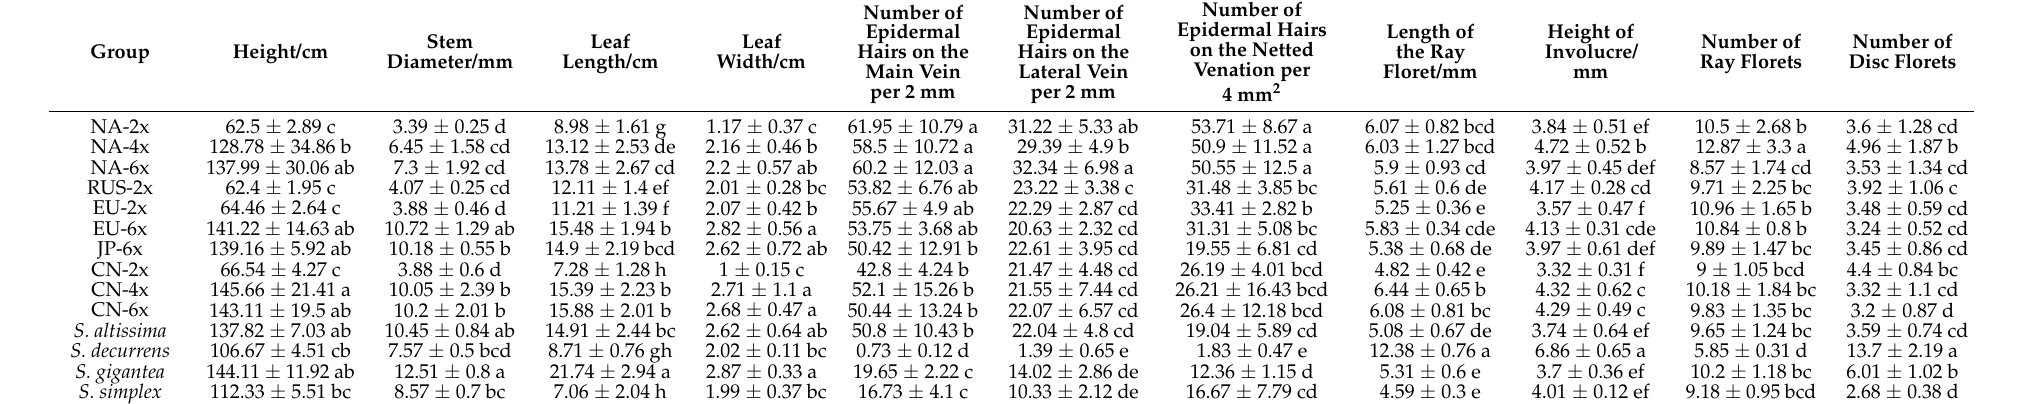
CN represents the population of China, EU represents the population of Europe, JP represents the population of Japan, NA represents the population of North America, and RUS represents the population of Russia; S. altissima includes populations of North America and Japan. Different lowercase letters indicate